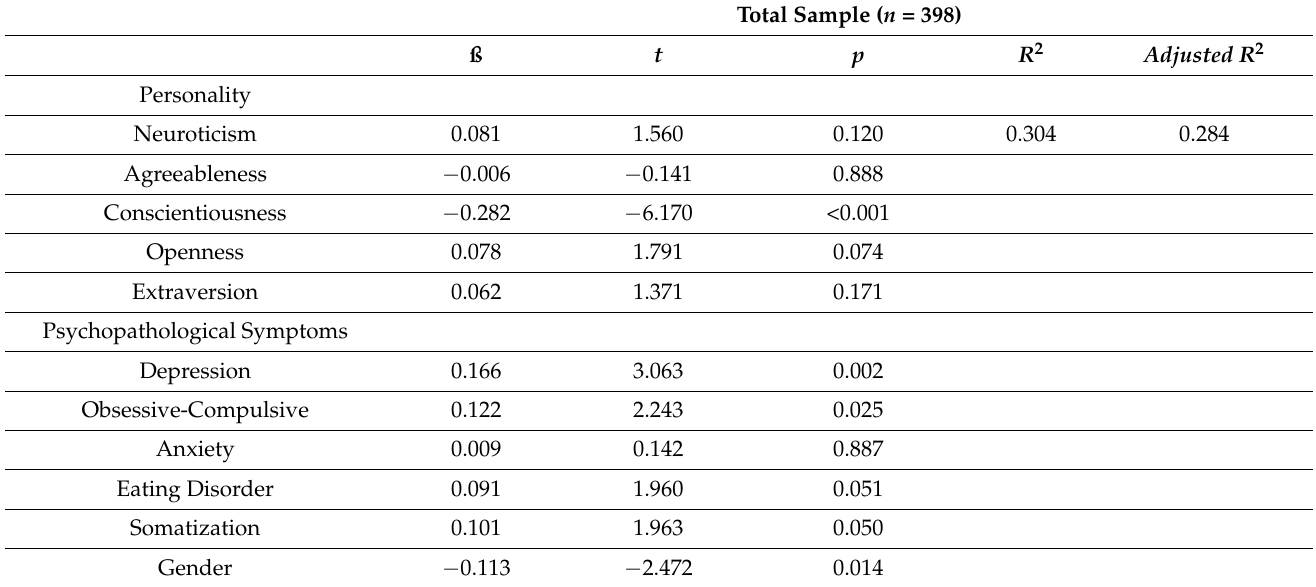
Table 3. Predictors of PSU.